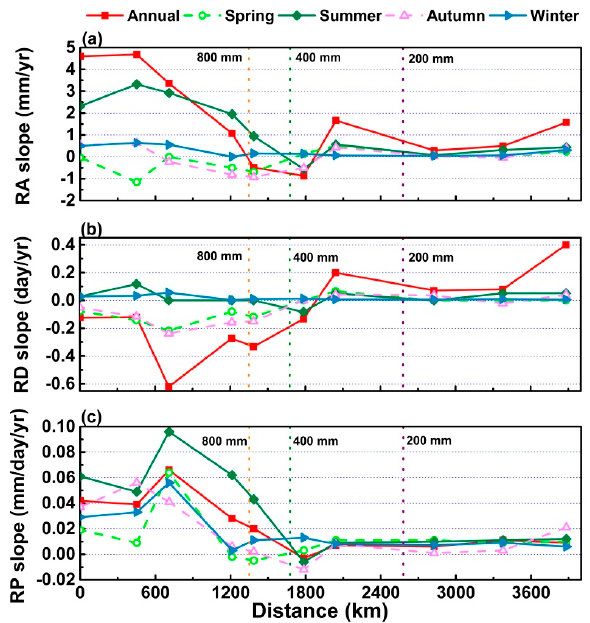
Figure 9. Spatial variation of Sen’s slope of the MK trend test for selected precipitation indices, including ( a ) rainfall amount (RA), ( b ) rainfall days (RD), and ( c ) daily precipitation on rainy days (RP) with distance from the sea. “800 mm” represents the 800-mm precipitation contour; “400 mm” represents the 400-mm precipitation contour; “200 mm” represents the 200-mm precipitation contour.